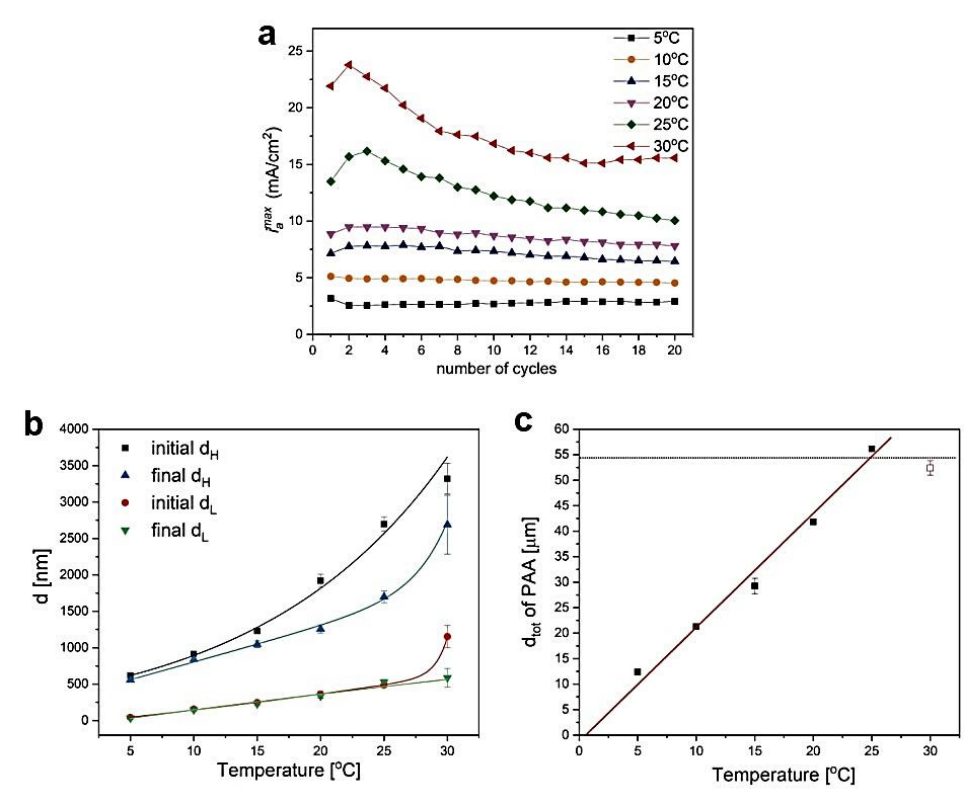
Figure 3. i amax as a function of the number of cycles ( a ) thickness of initial and final d H and d L segments as a function of anodizing temperature ( b ) total thickness (d tot ) of PAA membranes as a function of anodization temperature ( c ).